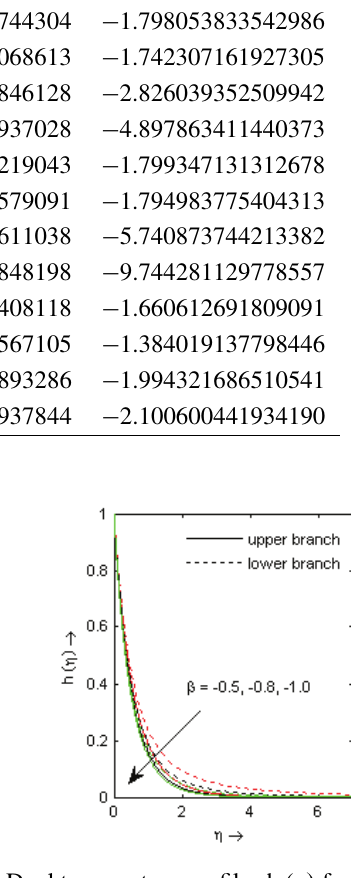
Figure 4. Dual temperature profiles h ( (cid:29) ) for various values of Pr with s